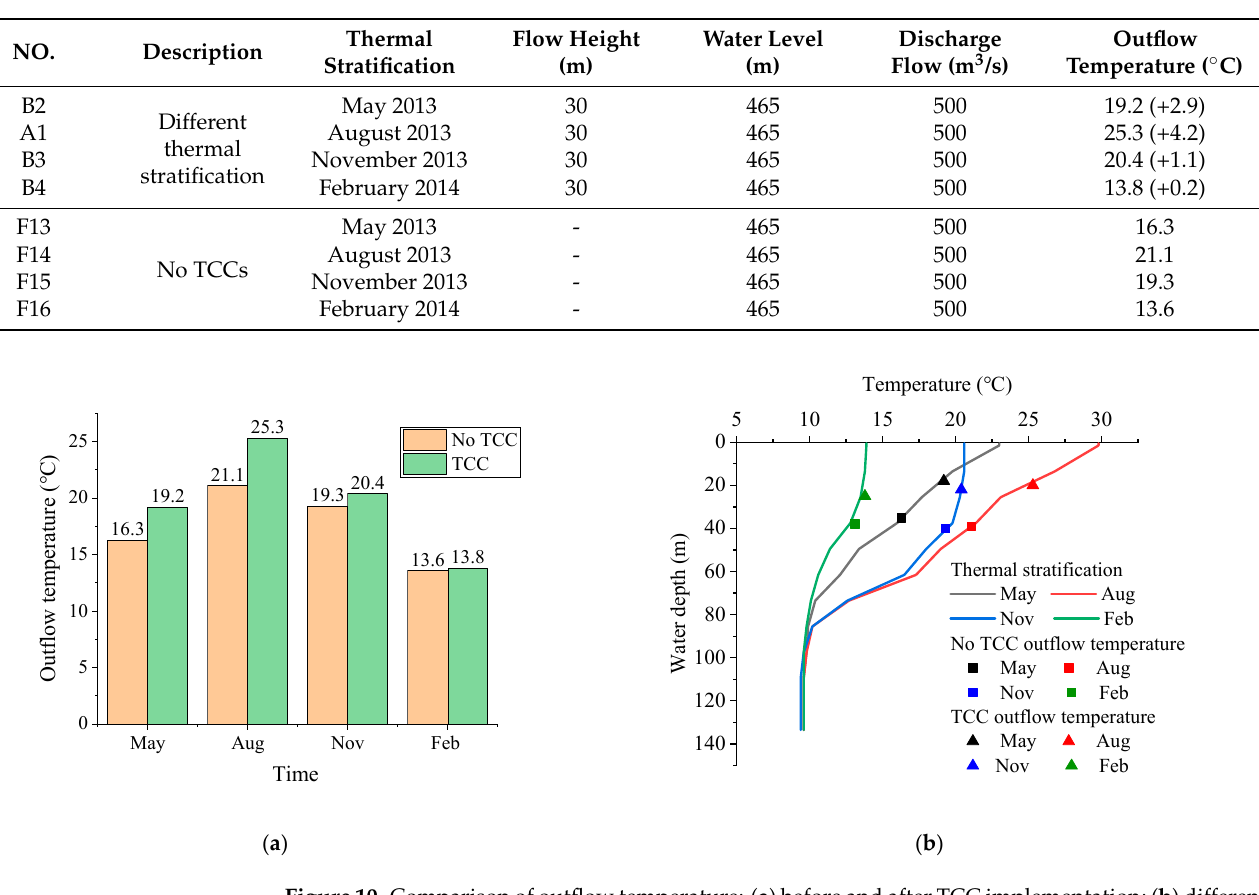
ferent thermal stratification. thermal